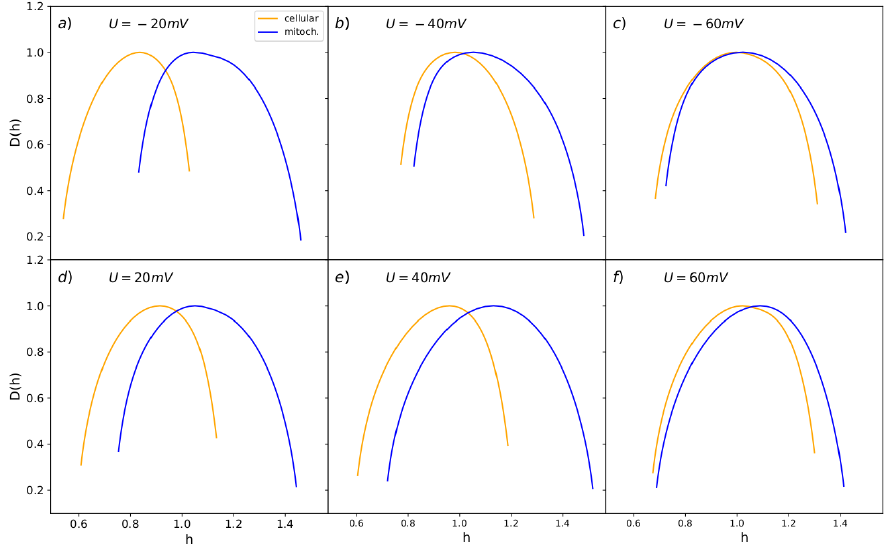
Figure 7. Average multifractal spectra obtained for BK channel from mitochondrial and cellular patches at different membrane potentials. The blue spectra characterize the mitoBK channel’s activity; the orange spectra are assigned to the BK channels from the cell membrane. The upper panels ( a – c ) present the results obtained at hyperpolarization; the lower graphs ( d – f ) correspond to the channels’ characteristics at membrane depolarization.